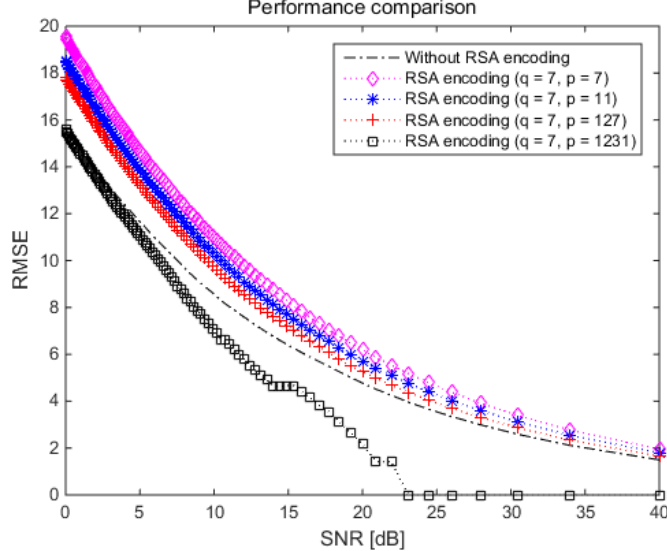
Figure 8. Root mean square error (RMSE) performance depending on various 𝑞 prime numbers in proposed VL communication technique based on asymmetric encryption scheme. Table 2. Public and private RSA key sets generated by various 𝑞 prime numbers.